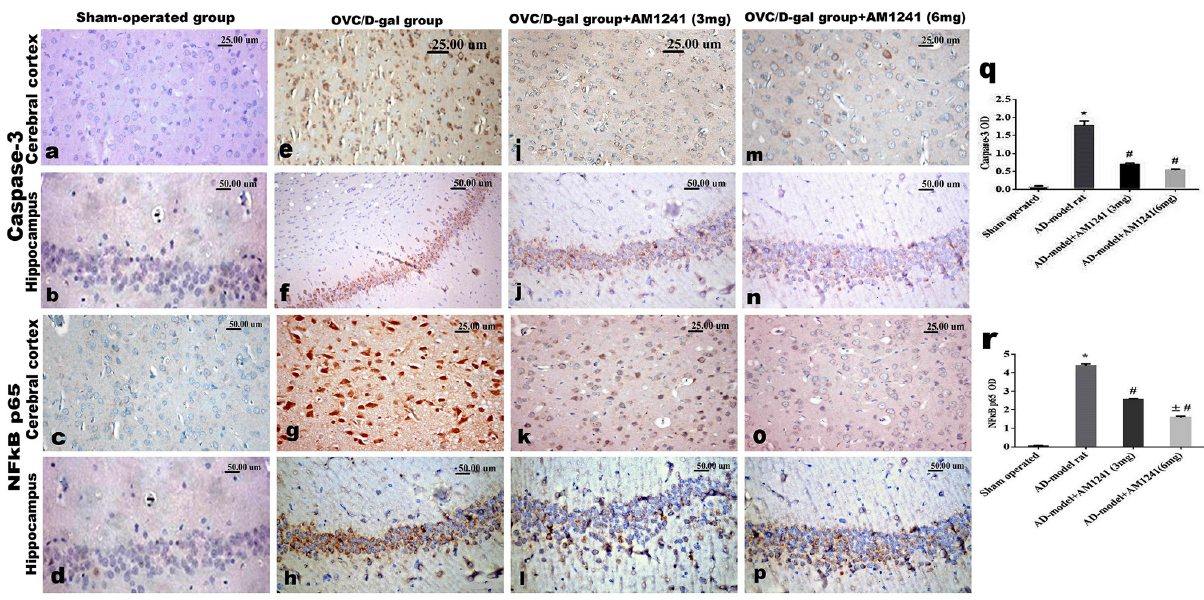
Fig 7. Photomicrographs of caspase-3 and NF κ B p65 immune-stained sections of frontal cortex and hippocampus. (a-d) Sham-operated group showing negative expression of caspase-3 and NF κ B p65. (e-h) OVC/D-gal group showing intense expression of caspase-3 and NF κ B p65 among the neuronal cells. AD-model rats’ which treated with AM1241, (i-l) 3mg/kg and (m-p) 6mg/kg showing marked decreased expression of caspase-3 and NF κ B p65 in a dose related response. (q and r) image analysis software for quantification of the positive expression of both caspase-3 and NF κ B p65 (data were analyzed by using one way ANOVA followed by Tukey’s post hoc test. Values expressed as mean ± SE (n = 5 rats/group). � , #, and ± statistically significant different at P < 0.05, where; � statistically significant different comparing with control group, # statistically significant different comparing with OVC/D-gal group, ± statistically significant different comparing with AM1241 (3mg/Kg).